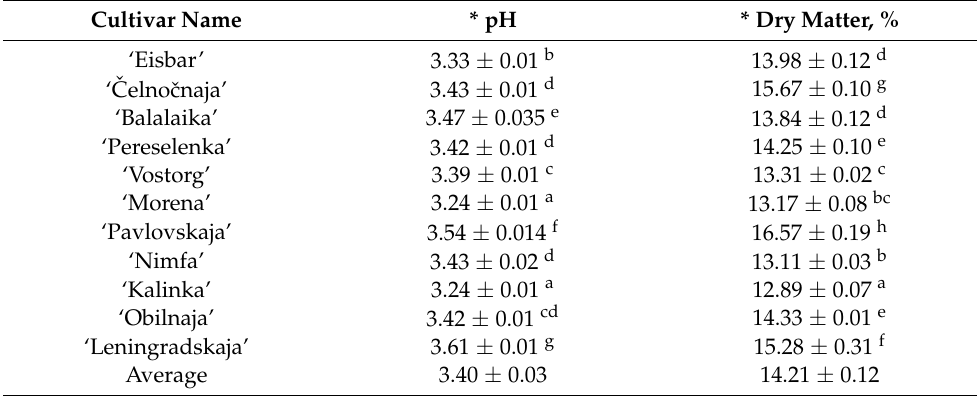
Table 2. Berry pH values and dry matter contents (means ± SD) of Lonicera caerulea cultivars. Cultivar